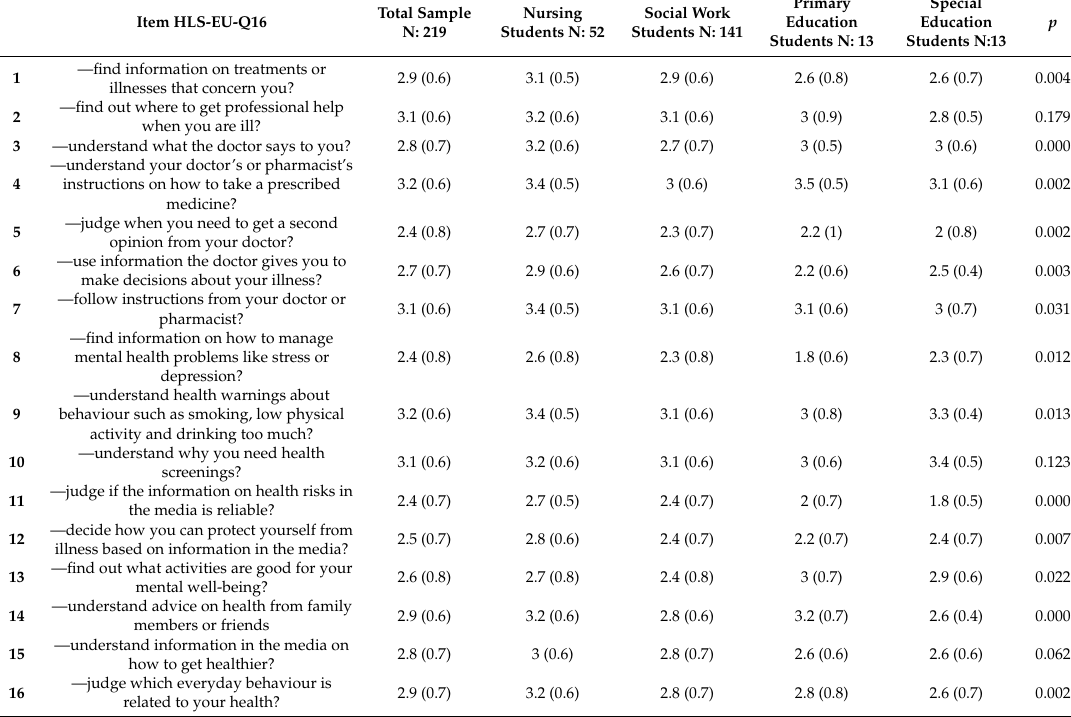
Table 1. Results of HLS-EU-Q16 scores in the total sample and by type of degree. Item HLS-EU-Q16 Total Sample N: 219 Nursing Students N: 52 Social Work Students N: